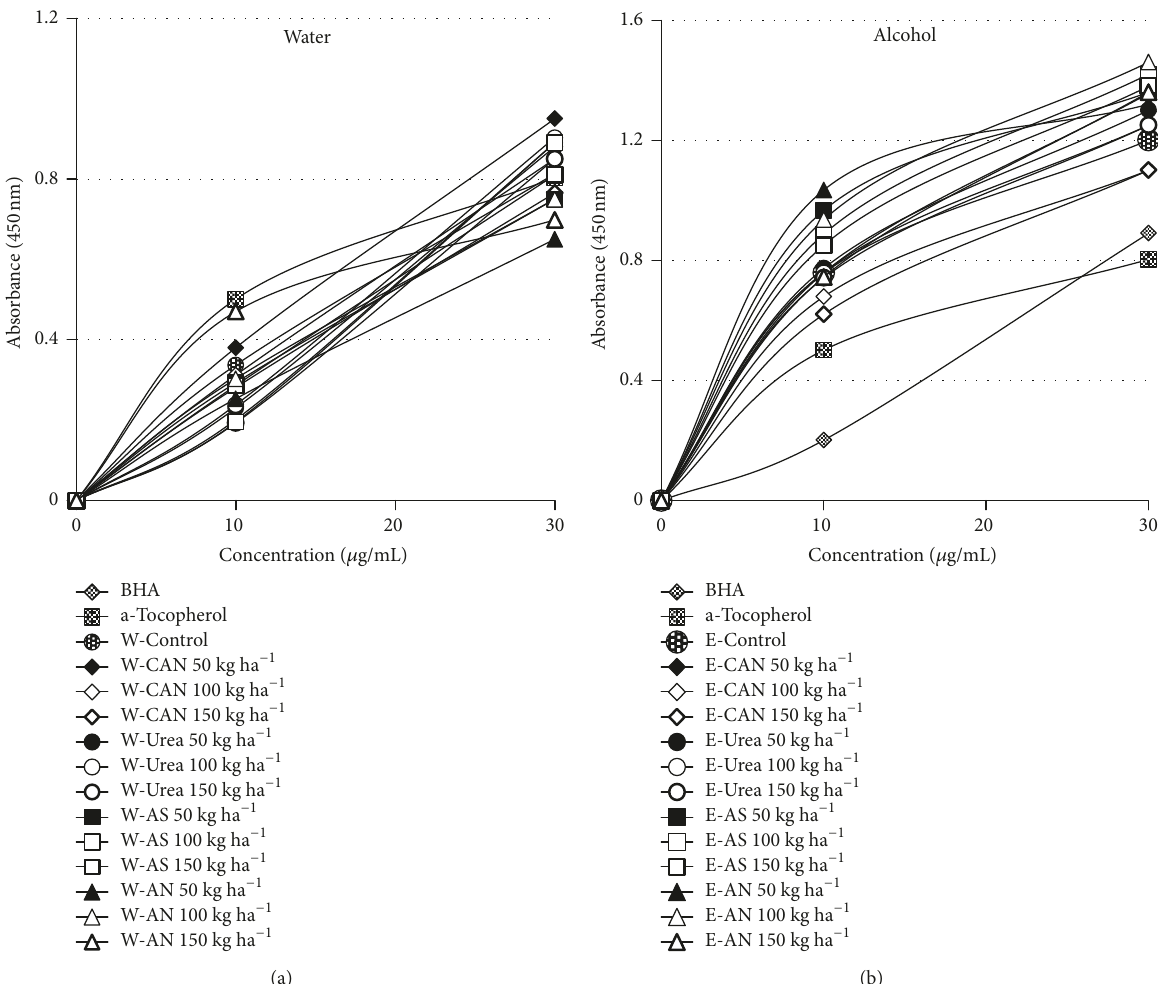
Figure 2: The Cu 2+ -Cu + reducing activity of water extracts, alcohol extracts, BHA, and 𝛼 -tocopherol at different concentrations (10–30 𝜇 g/